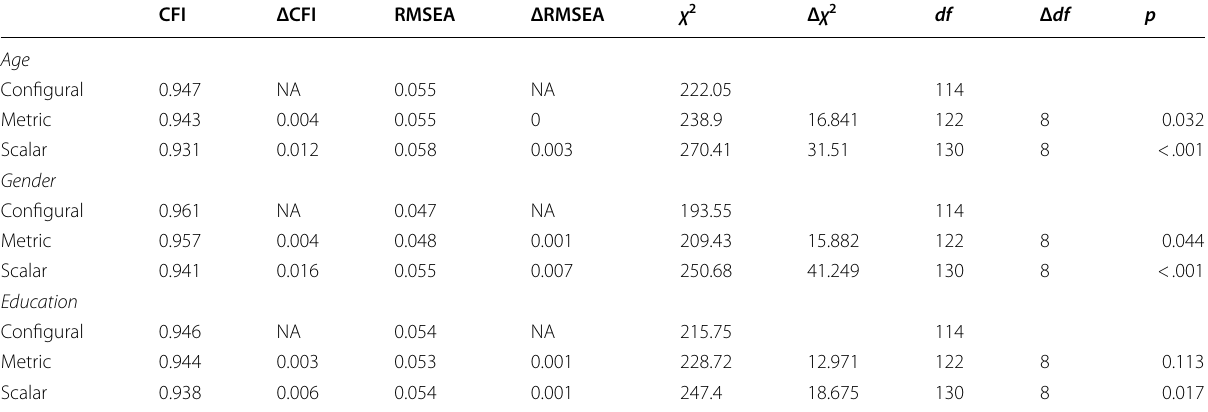
Table 8 Change in goodness-of-it indices for selected demographic